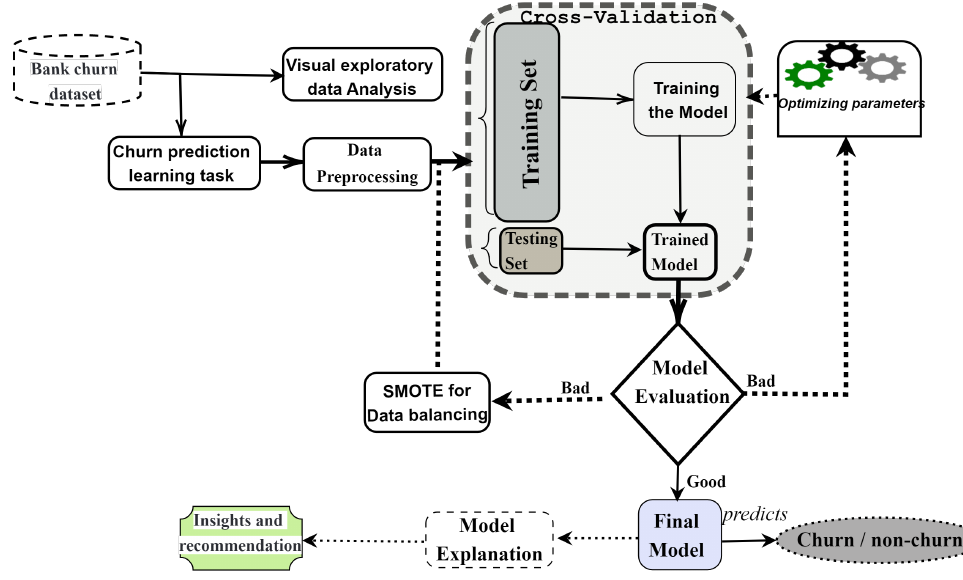
Figure 1. Flowchart of the proposed